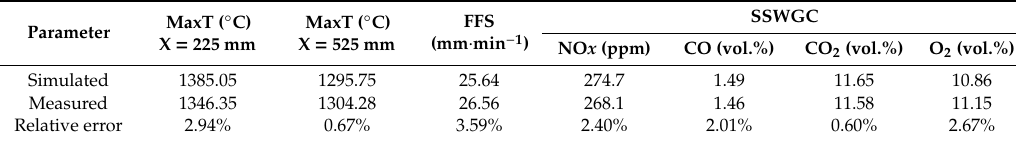
Table 3. Comparison of simulation and measured